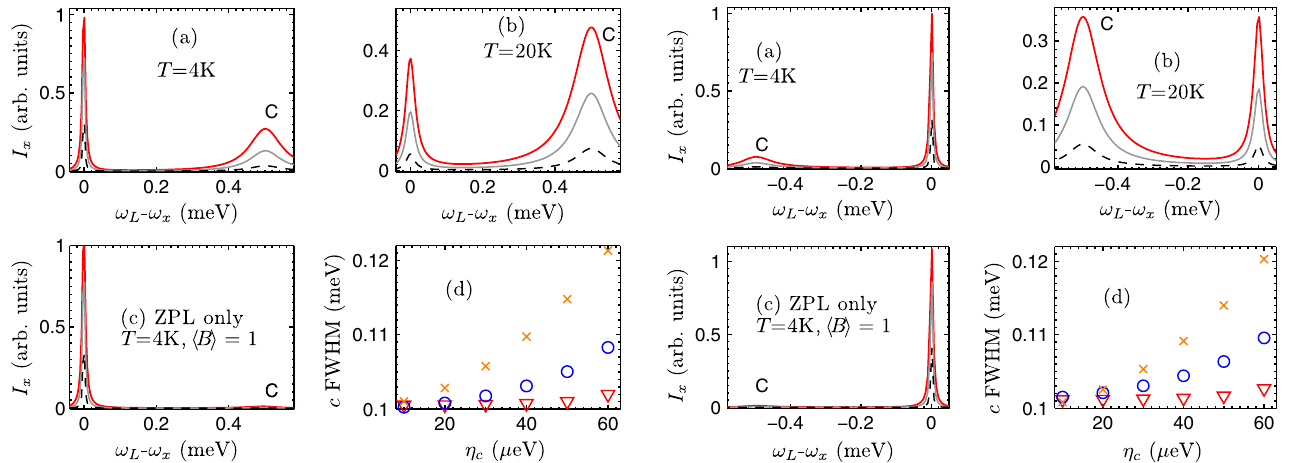
FIG. 12. As in Fig. 10, but for the exciton intensity obtained in the presence of a cavity pump. The cw drive strengths are (cid:4) 10 ; 40 ; 60 (cid:8) eV . In (d), the orange crosses show the c FWHM at T ¼ 20 K , the blue circles at T ¼ 4 K , and the inverted red triangles show the FWHM with only ZPL broadening and h B i ¼ 1 . The cavity-exciton detuning is (cid:1)